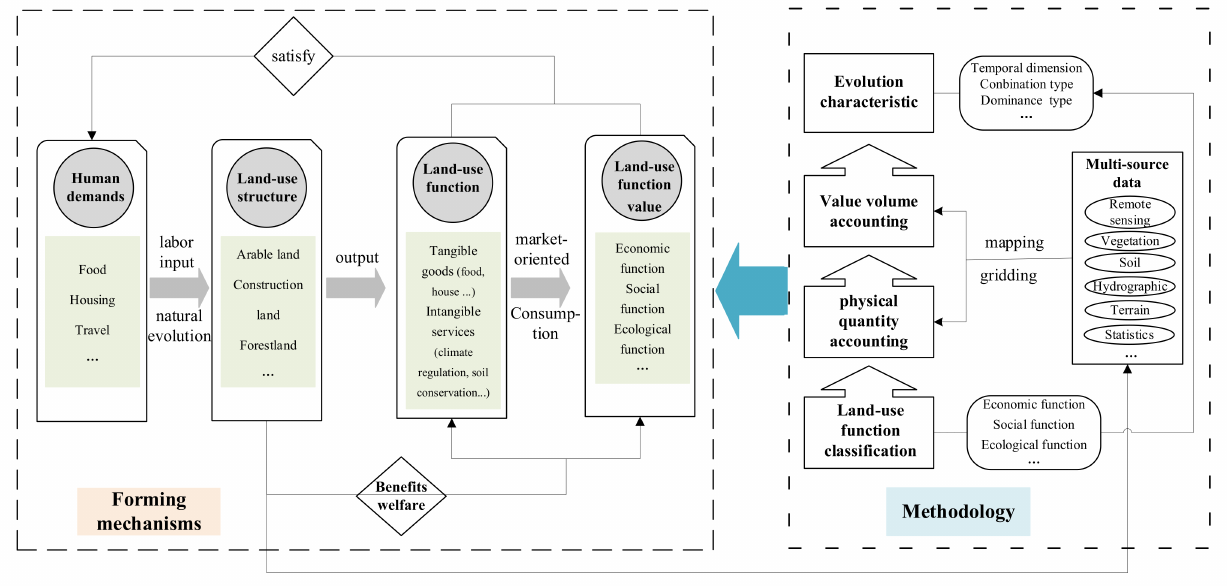
Figure 1. The analytical framework for analyzing LUFs value and their